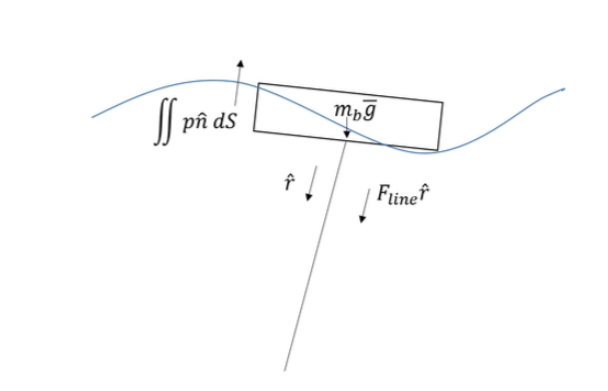
Fig. 2. The forces acting on the buoy are the sum of hydrodynamic and gravitational forces, as well as the forces from the generator. The F line is directed toward an anchor point